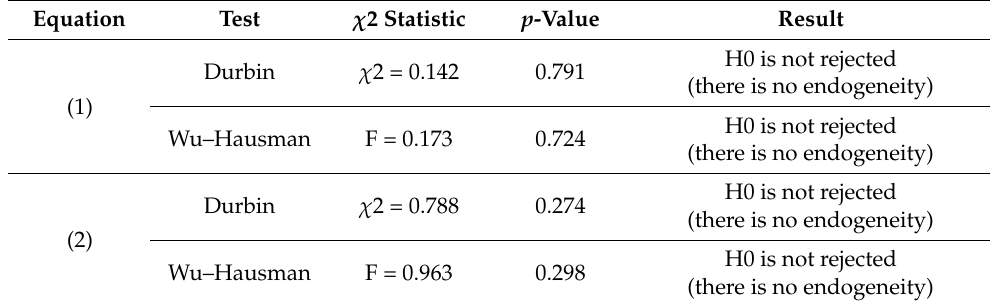
Table 3. Results of Durbin–Wu–Hausman